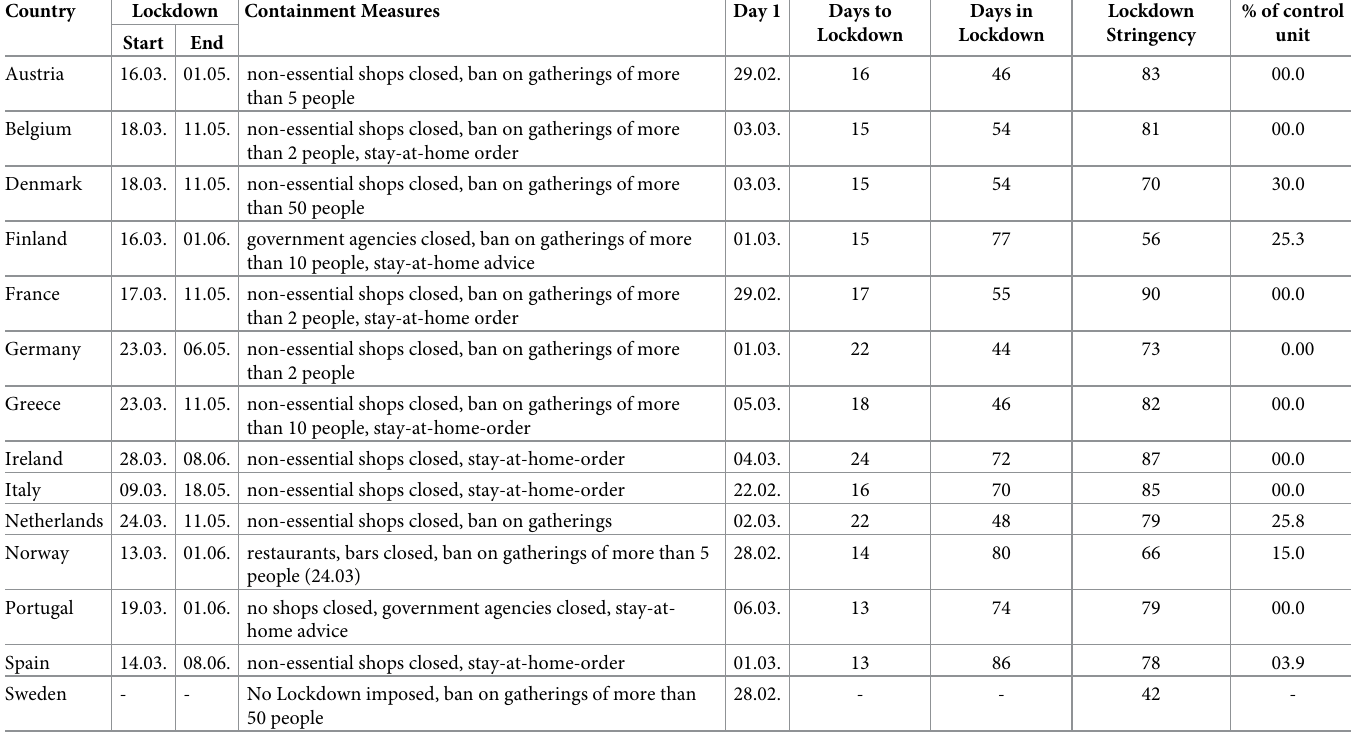
Table 1. Donor pool and Sweden during the first wave: Lockdown measures and